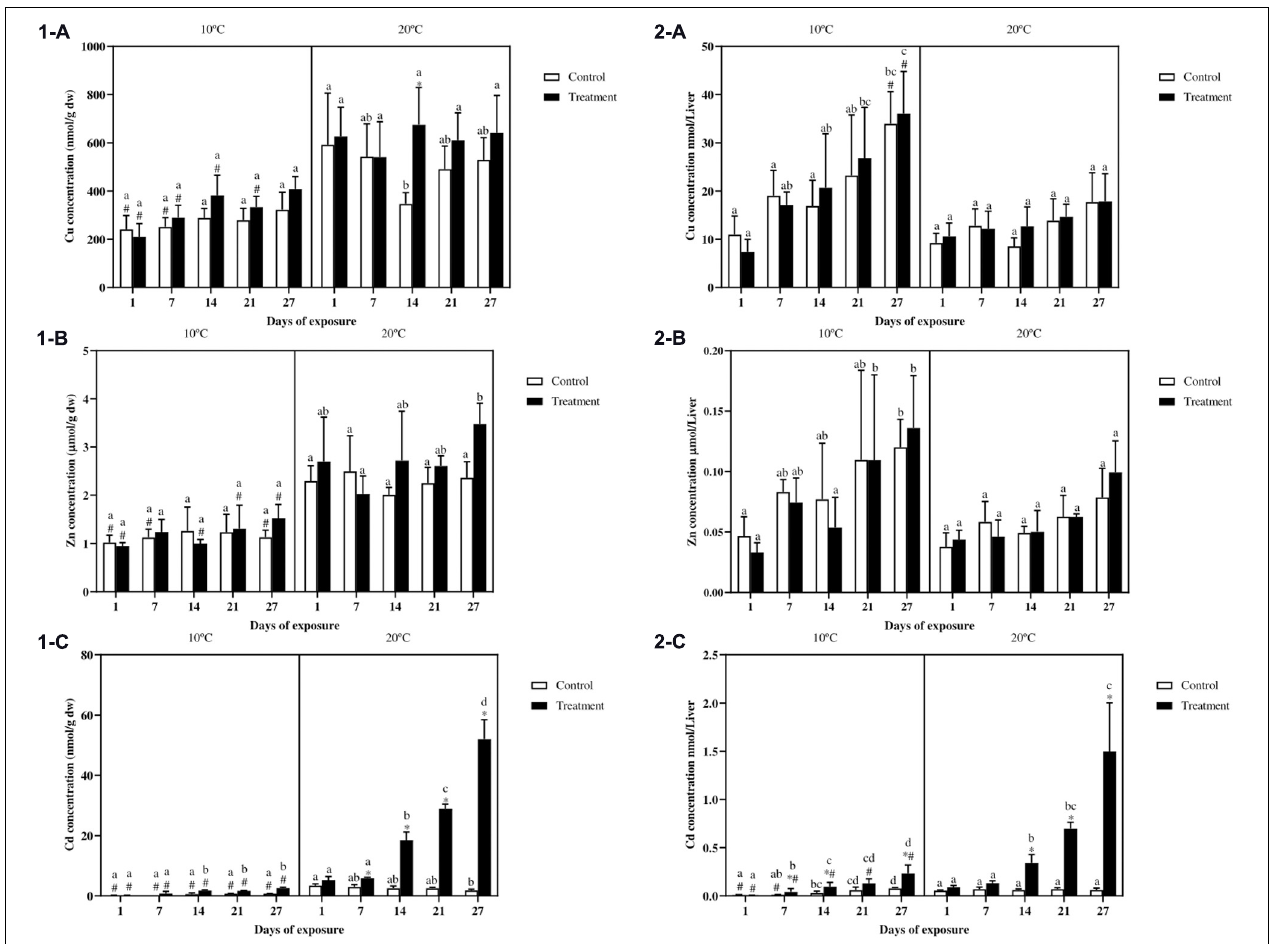
FIGURE 3 | Cu (1-A) , Zn (1-B) , Cd (1-C) expressed as nmol/g dw or as µ mol/g dw in the liver and Cu (2-A) , Zn (2-B) , Cd (2-C) expressed as total amount in nmol or µ mol per liver in common carp exposed to a mixture of Cu, Zn, and Cd for 27 days both at 10 ◦ C and 20 ◦ C. Mean + SD, N = 5. Mean ± SD. Asterisks ( ∗ ) indicate differences between control and metal treatment at each sampling day, the hash (#) indicates differences between the same groups (both control and metal treated) at different temperatures, and lowercase letters indicate significant differences of the same groups among sampling days at each temperature ( p <